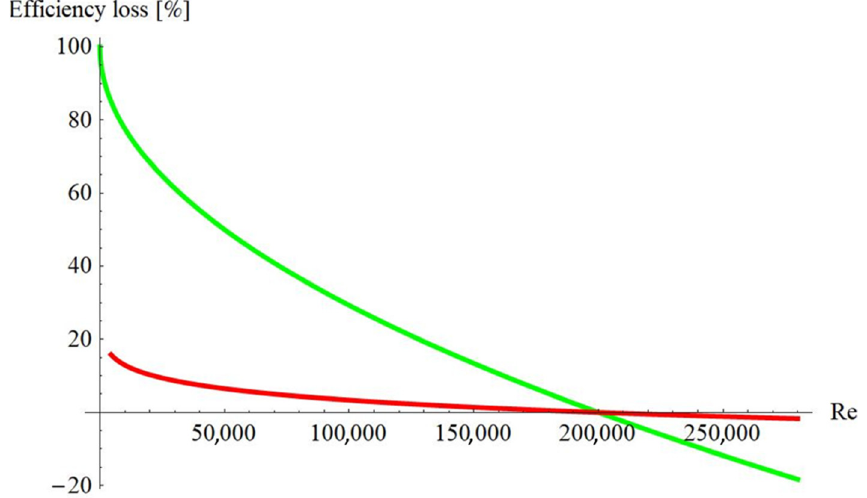
Figure 1. Efficiency loss according to Equation (3). The red line is for a = 0.5 and n = 0.1, while the green line is for a = 0 and n = 0.5. In this case, Re ref is